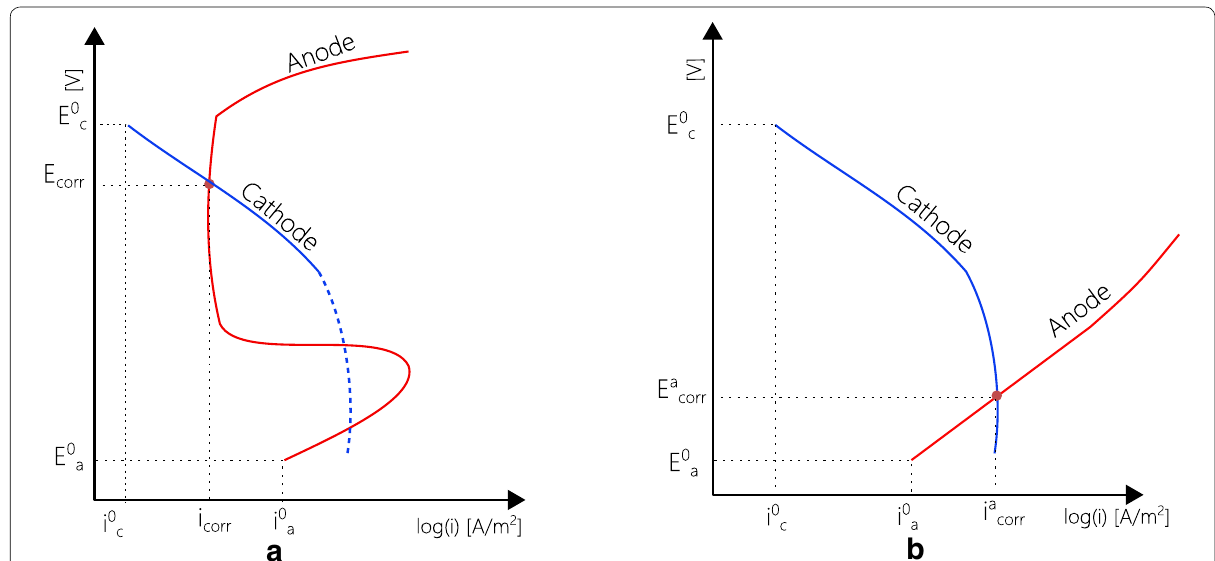
Fig. 4 Schematic representation of the electrochemical kinetics of steel in concrete undergoing depassivation. a Passivated condition ( Cl < Cl th ). b Depassivated-condition ( Cl > Cl th